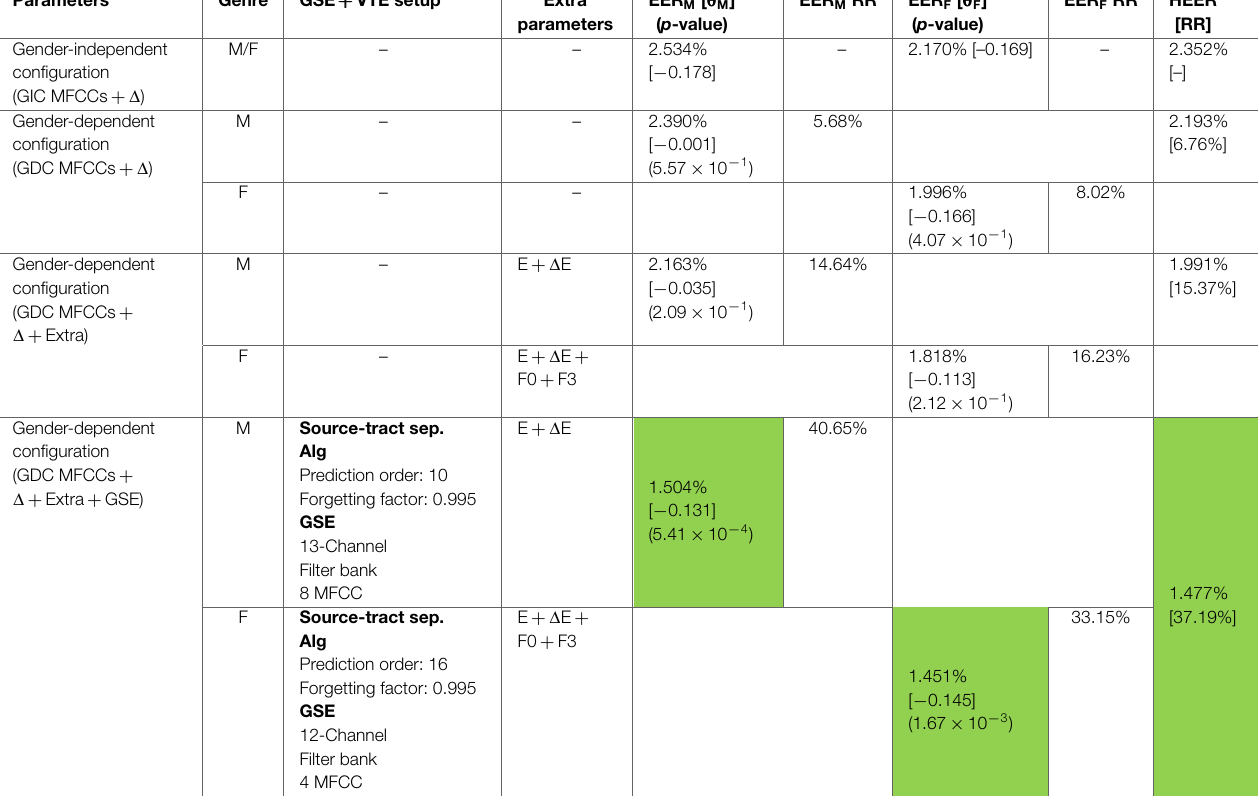
TABLE 3 | EER M , EER F , and HEER obtained on development set (no score normalization), comparing classical parameters with extra parameters and extended biometric parameters for the configurations providing the most successful results [RR !!! Relative Reduction/[threshold]/( p -value)] . Parameters